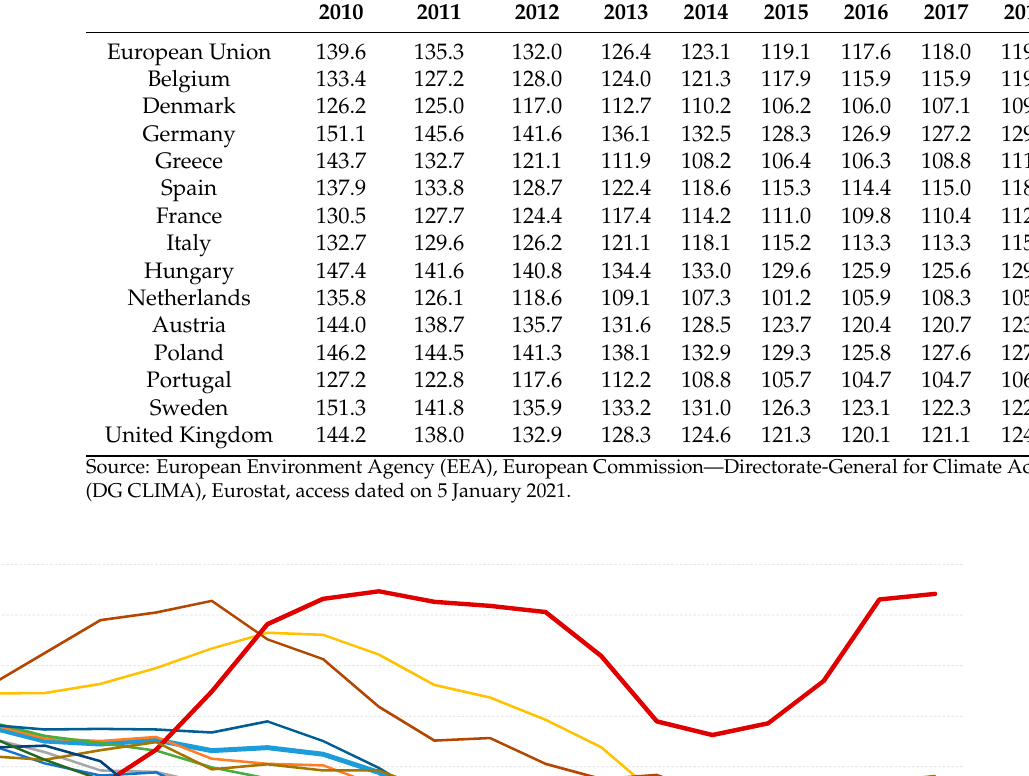
Table 1. Average CO 2 emissions per km (new passenger cars).